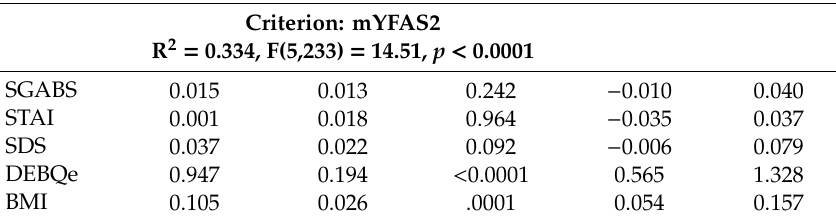
STAI: State-Trait Anxiety Inventory. SGABS: Shortened General Attitude Belief Scale. SDS: Self-report Depression Scale. DEBQe: Dutch Eating Behavior Questionnaire Emotional Eating. mYFAS2: Modified Food Addiction Scale